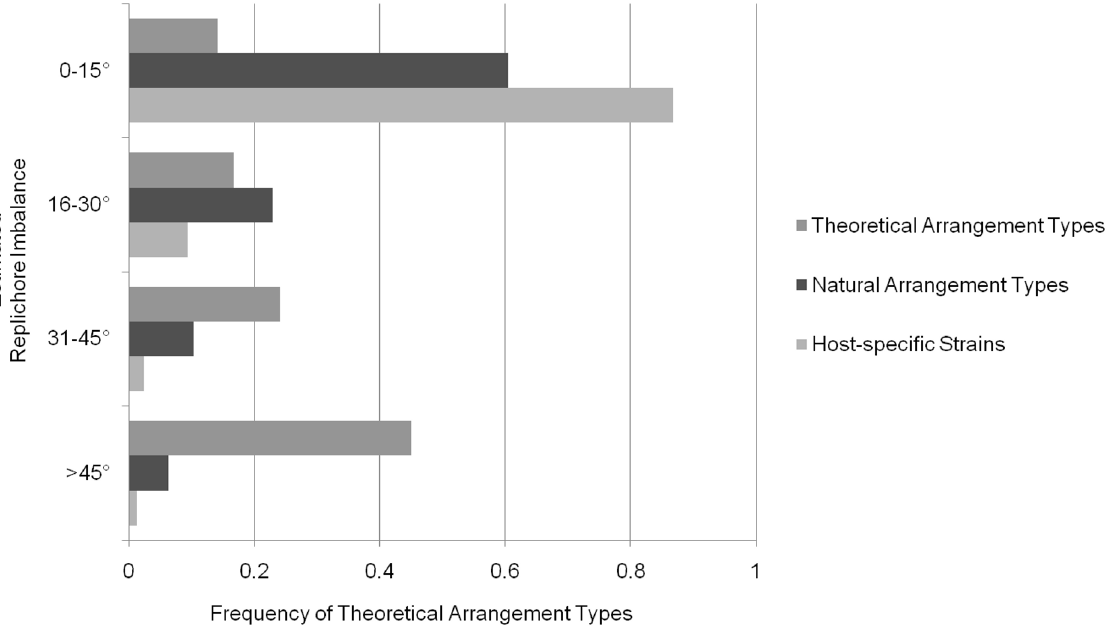
Figure 5. The estimated replichore imbalance of theoretical arrangement types, natural arrangement types, and host-specific strains. Estimated replichore imbalance was divided into four groups with every 15 u increase of imbalance, and compared to the frequency of theoretical arrangement types. Most host-specific strains and natural arrangement types had well-balanced replichores ( , 15 u imbalance), whereas most theoretical arrangement types had imbalanced replichores ( . 30 u imbalance).